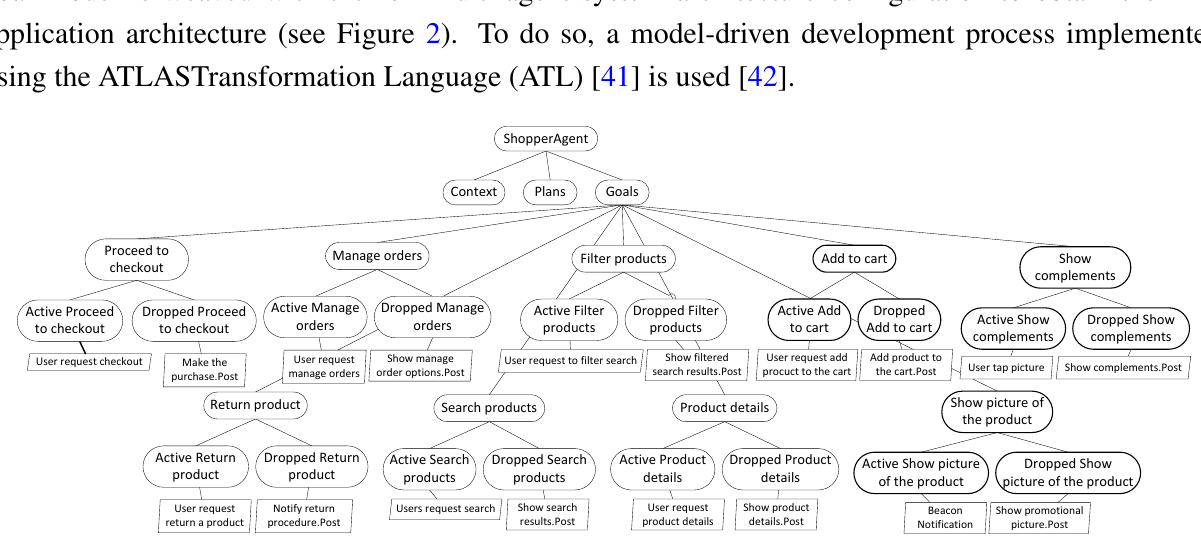
Figure 7. Partial view of the goal model of ShopperAgent